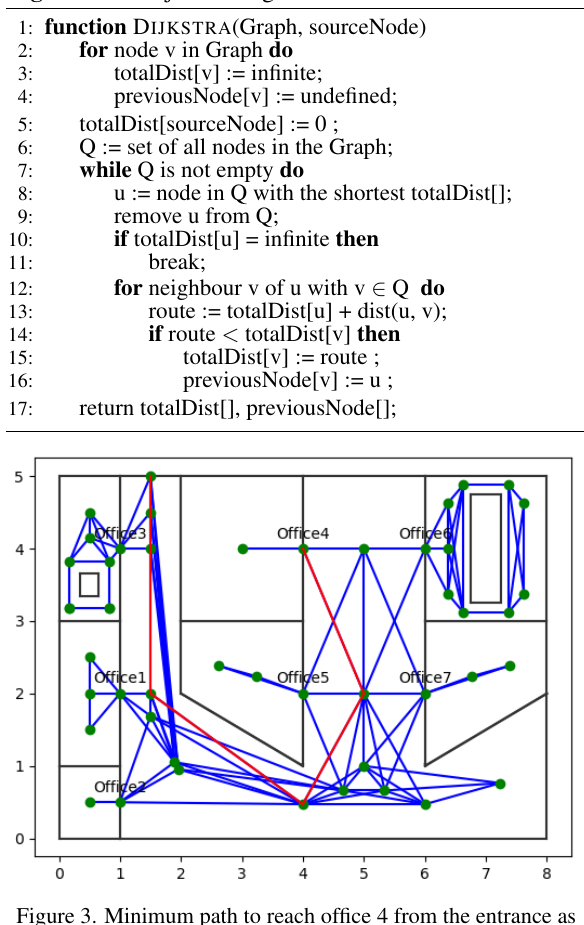
Figure 3. Minimum path to reach office 4 from the entrance as calculated by the Dijkstra algorithm